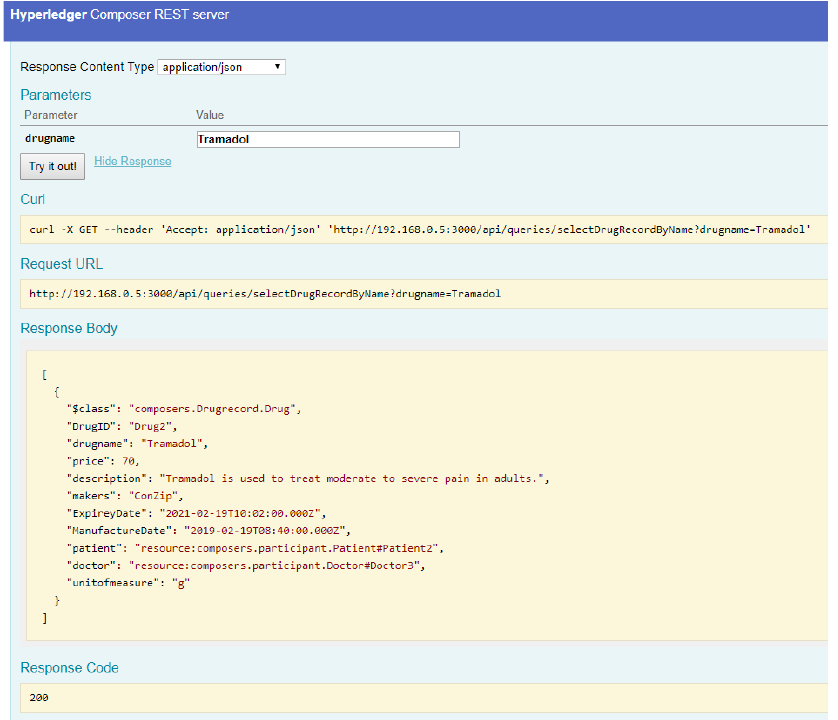
Figure 20. Fetching drug record through the Composer REST